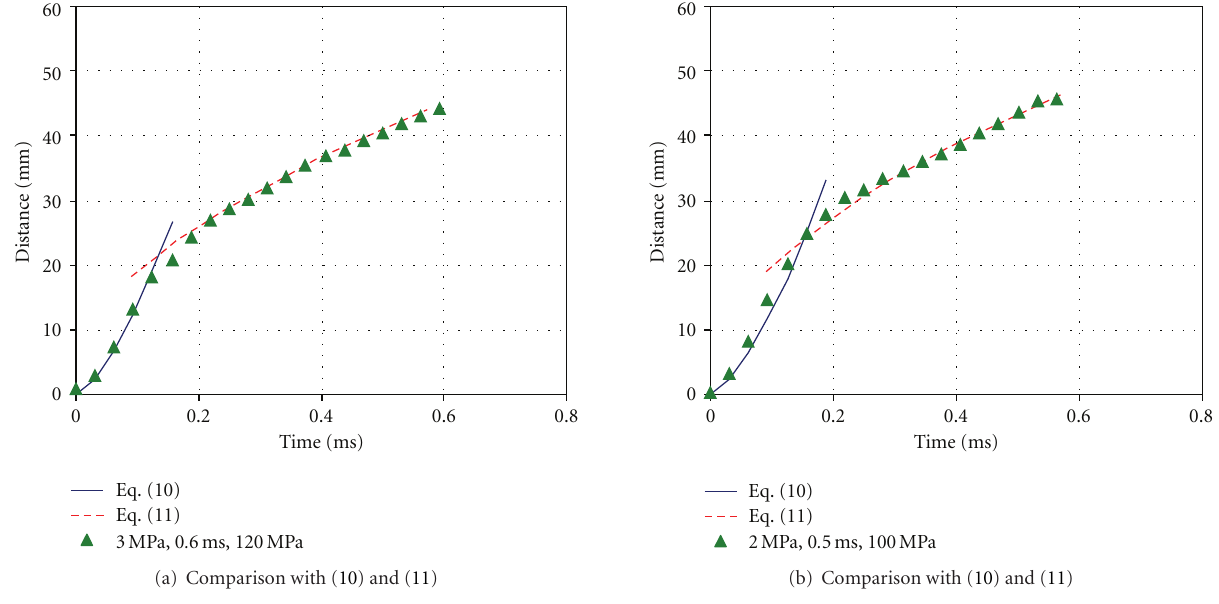
Figure 13: Comparison of experimental results with (10) and (11), Nozzle A.